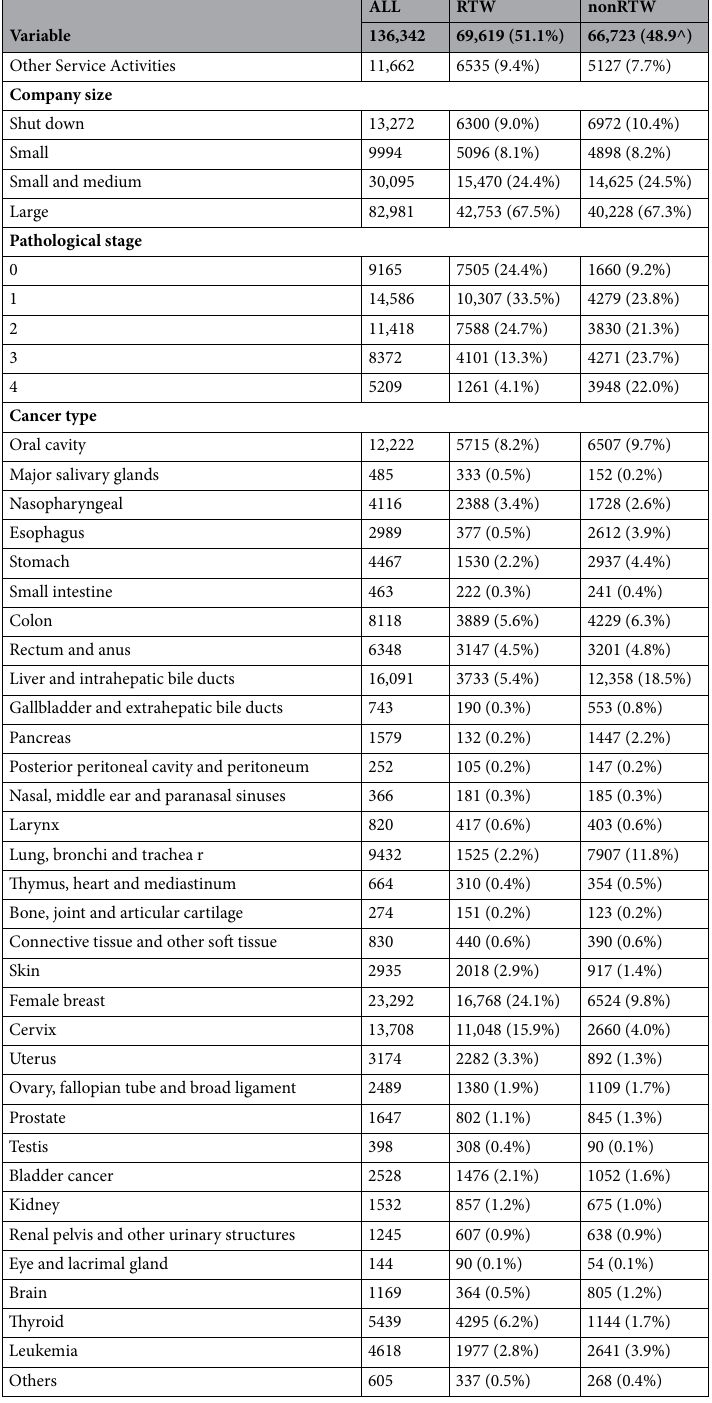
Table 1. Demographic data of RTW group and non-RTW group in the 5th